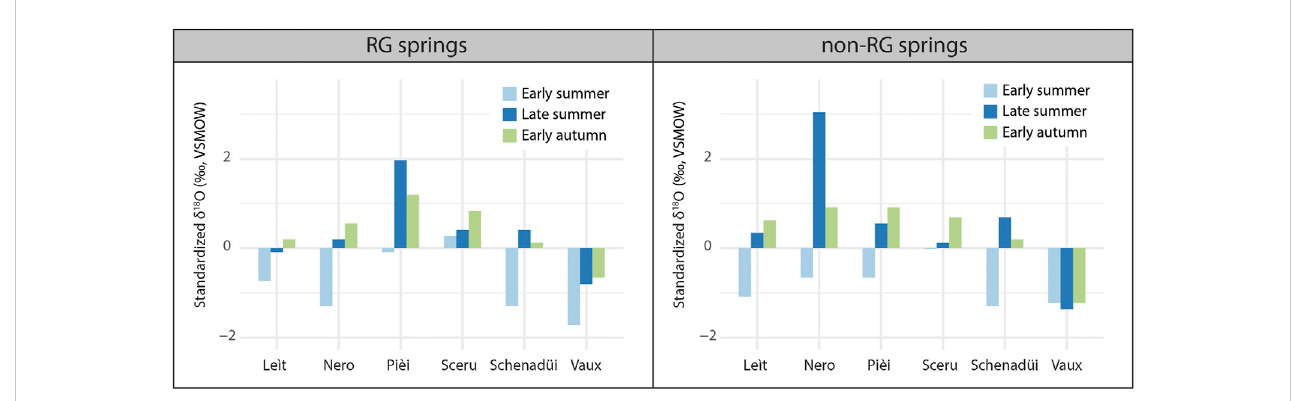
FIGURE 7 δ 18 O values measured in RG springs (left column) and non-RG springs (right column) during the warm season. Values were standardized using